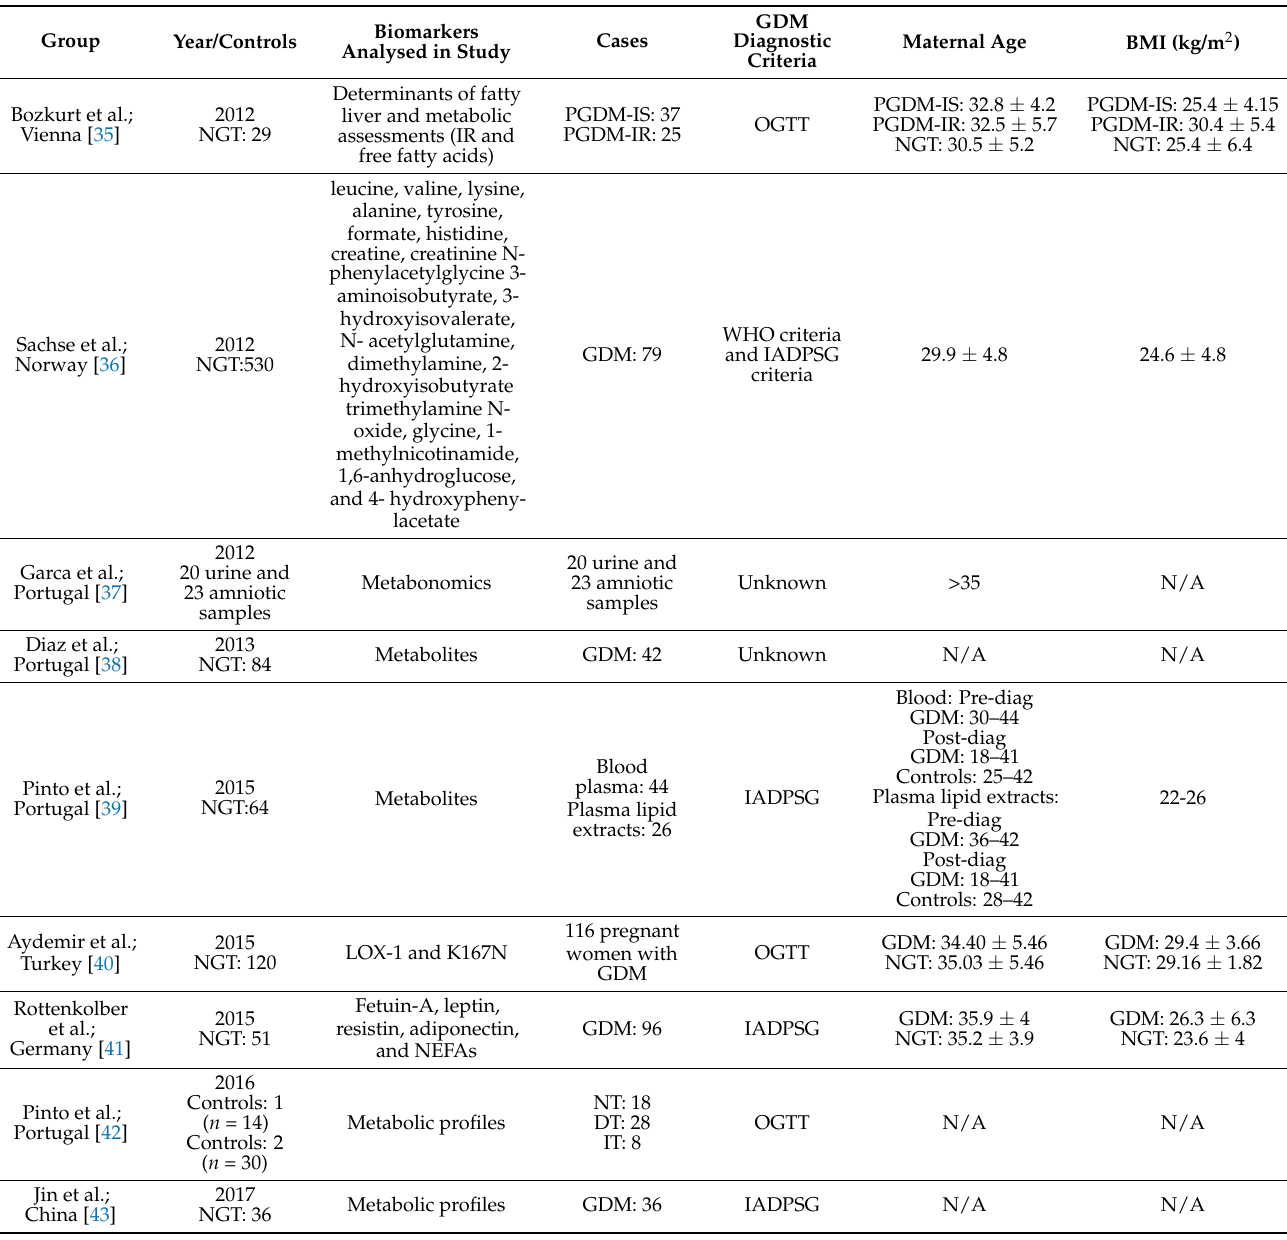
and lines broadened